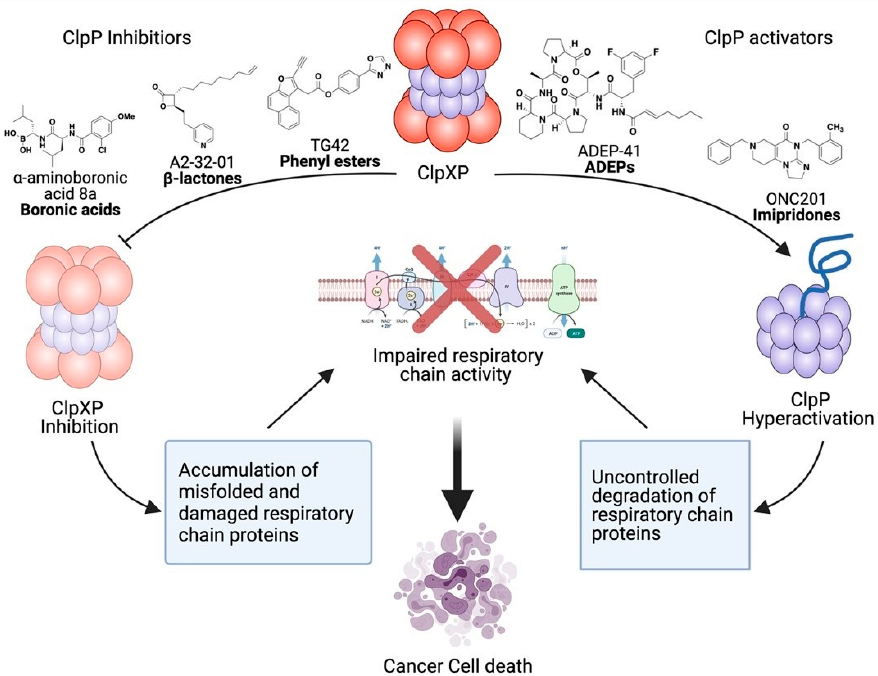
Figure 2. ClpXP inhibition and hyperactivation lead to cancer cell death. Genetic and chemical inhibition of ClpXP leads to the accumulation of misfolded and damaged respiratory chain proteins and impairs oxidative phosphorylation which results in selective cancer cell death. ClpP chemical activators and mutated hyperactive ClpP result in uncontrolled degradation of ClpP substrates. ClpP hyperactivation causes mitochondrial morphological damage and decreased oxidative phosphorylation, which also results in cancer cell death.